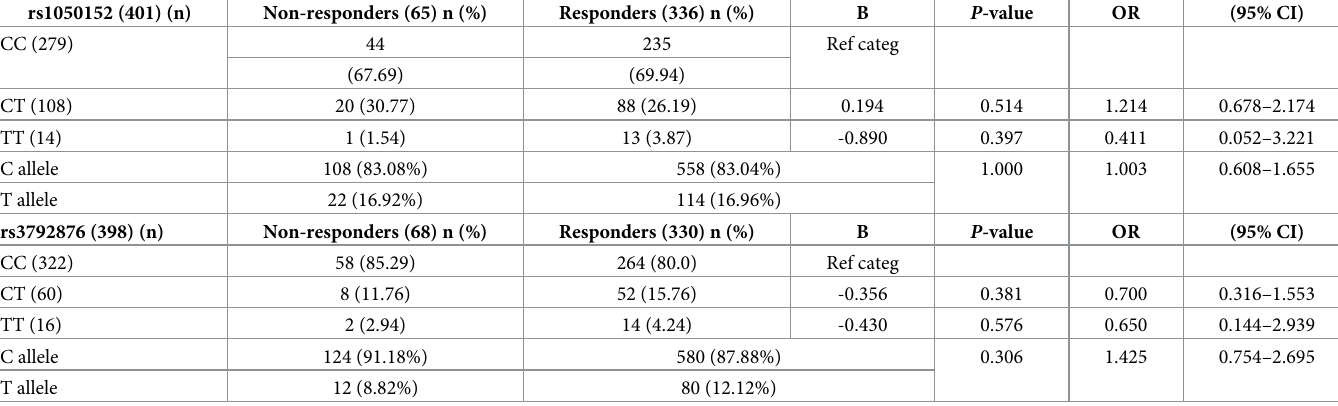
Table 2. OCTN1 (rs1050152 and rs3792876) genotype, allelic distribution among responders (complete and partial) and non-responders. rs1050152 (401)